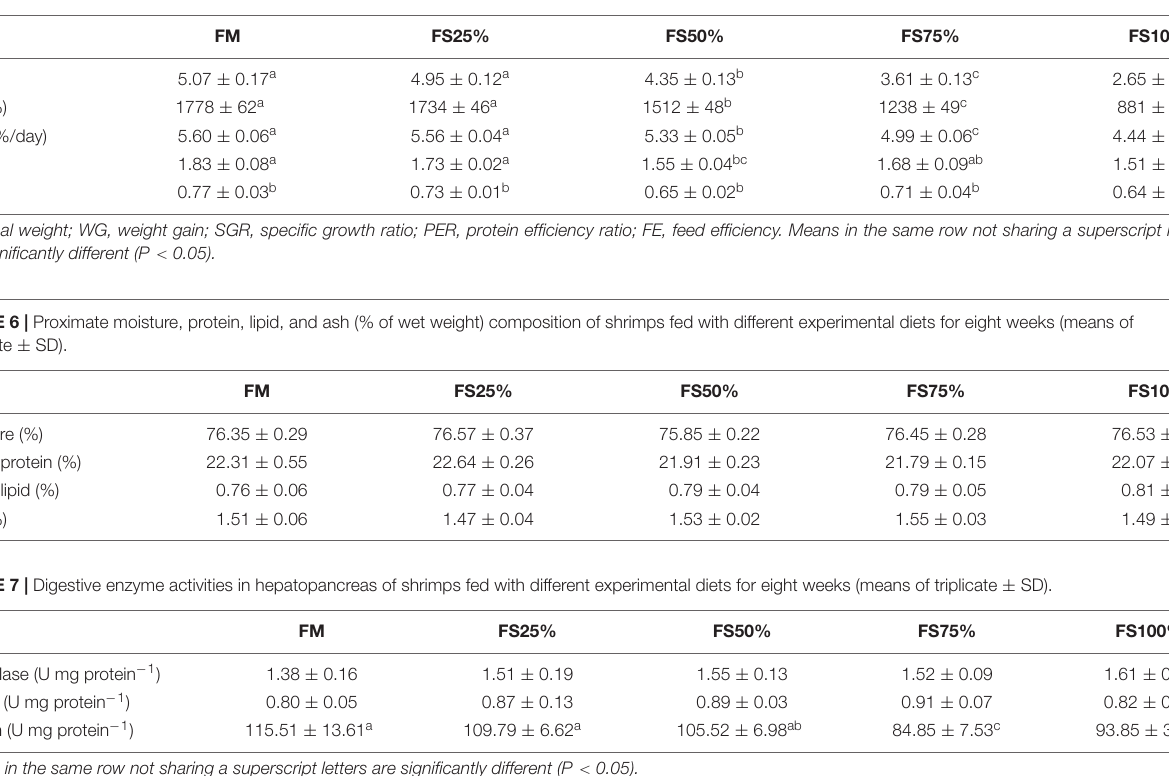
Means in the same row not sharing a superscript letters are significantly different (P < 0.05).